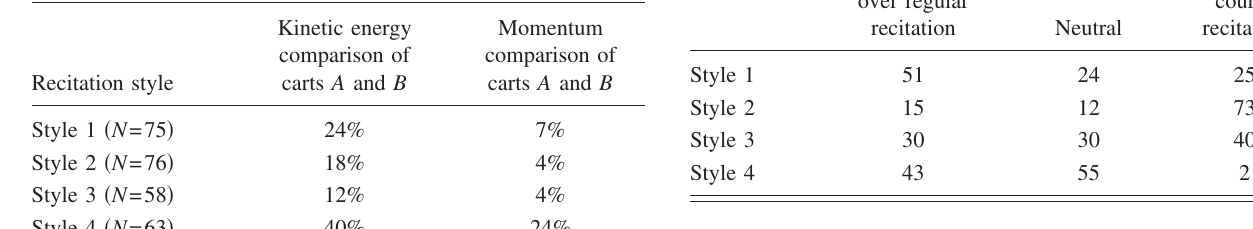
TABLE VII. Students who acknowledged but incorrectly ap- plied the theorems on post-test question 1. Note that no students acknowledged these theorems on the pretest without applying them correctly.